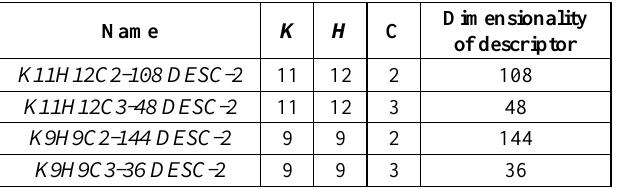
Table 2. Different pooling configurations of DESC-2.